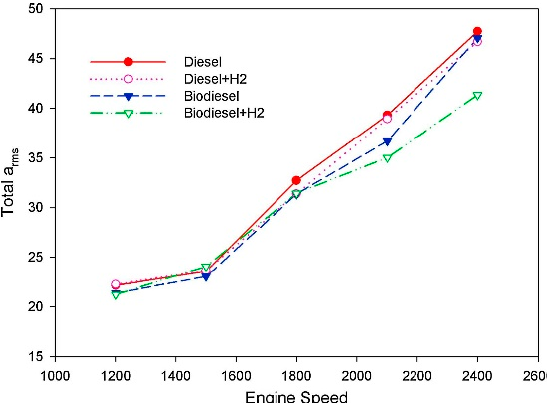
Figure 17. a total (total vibration acceleration) of diesel, biodiesel and their hydrogen enriched blends [136].